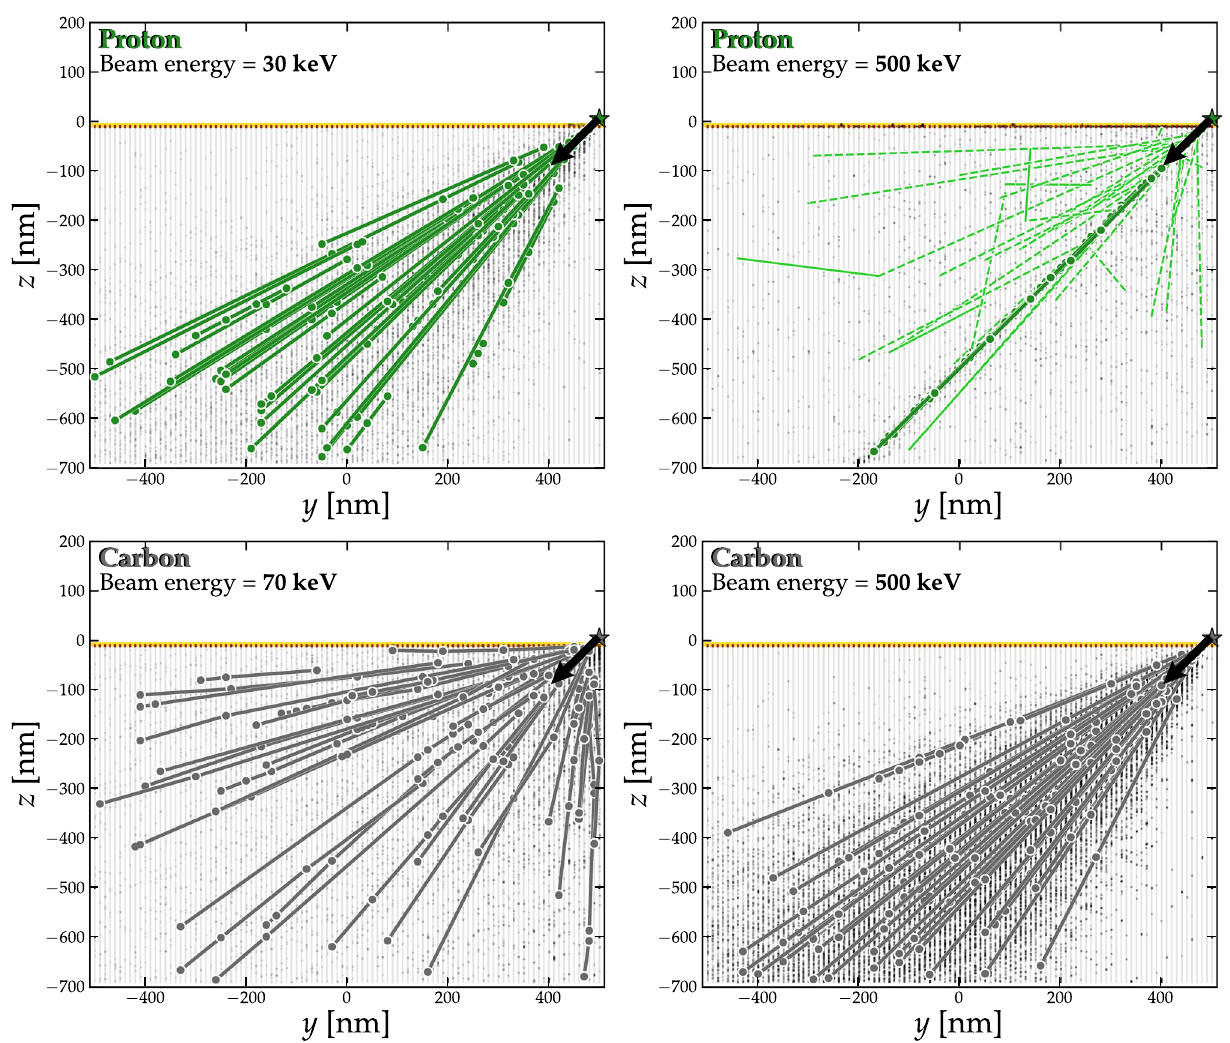
Fig. 4 Distribution of DNA breakage sites for 30 and 500 keV protons (top row), and 70 and 500 keV carbon nuclei (bottom row) incident on the holder (gold layer at z = 0) at an angle of 45 ◦ . The faint vertical gray lines represent DNA strands. Green and grey thick lines represent a random sample (out of a total of 10 4 primary particles per beam) of 40 proton and carbon primary tracks, respectively, determined as ‘measur-